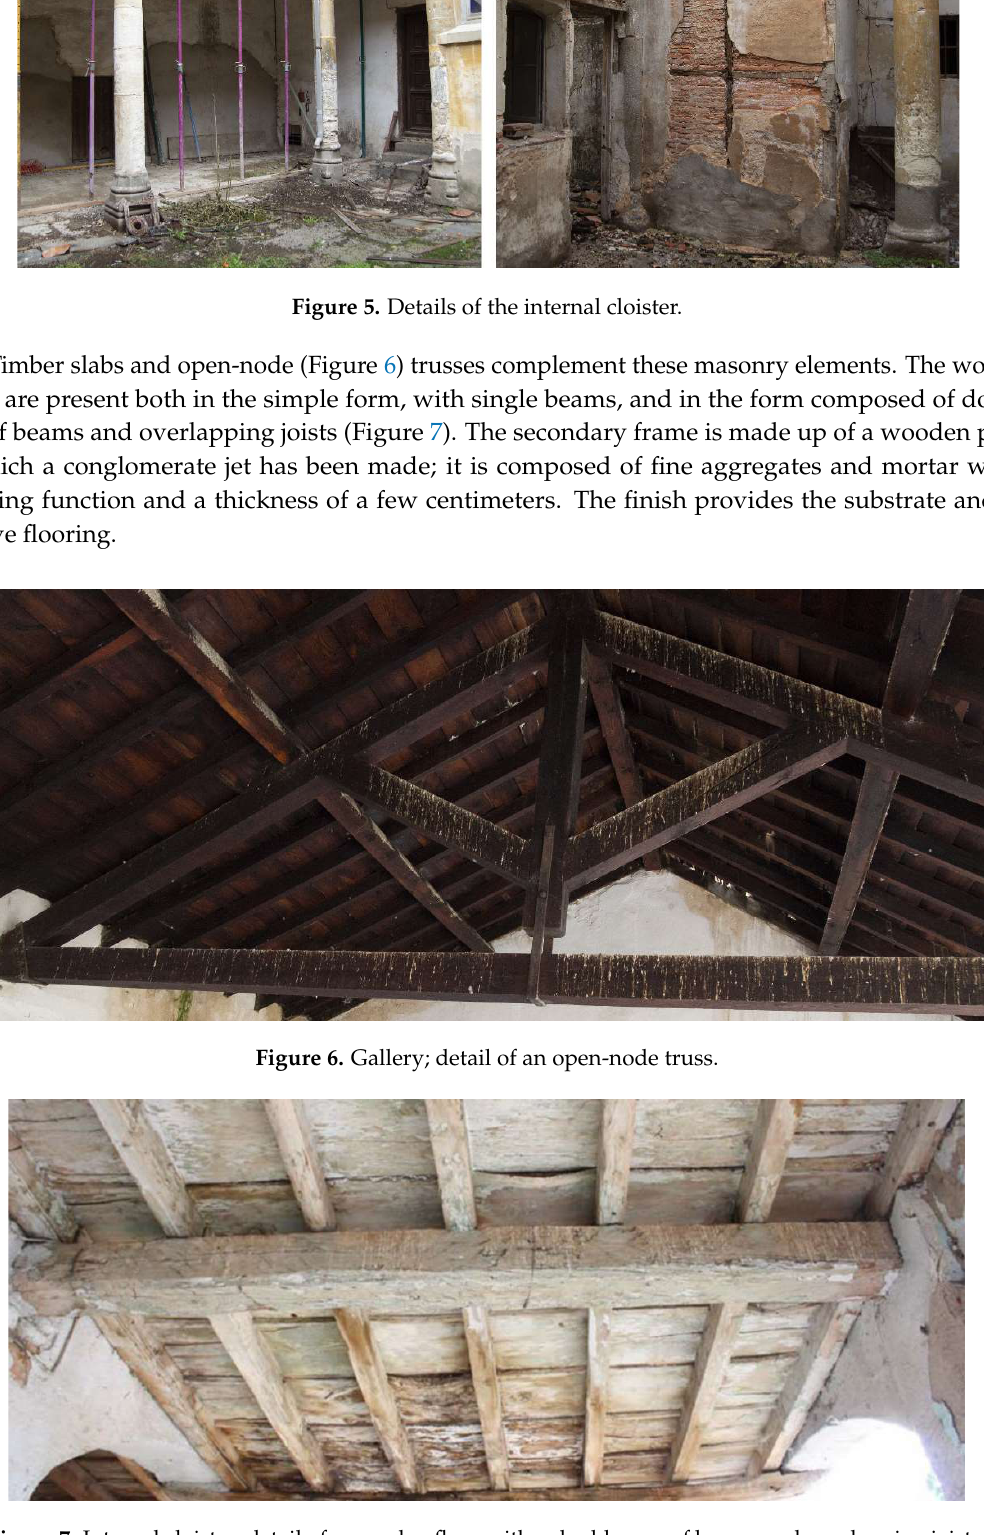
Figure 7. Internal cloister; detail of a wooden floor with a double row of beams and overlapping joists.